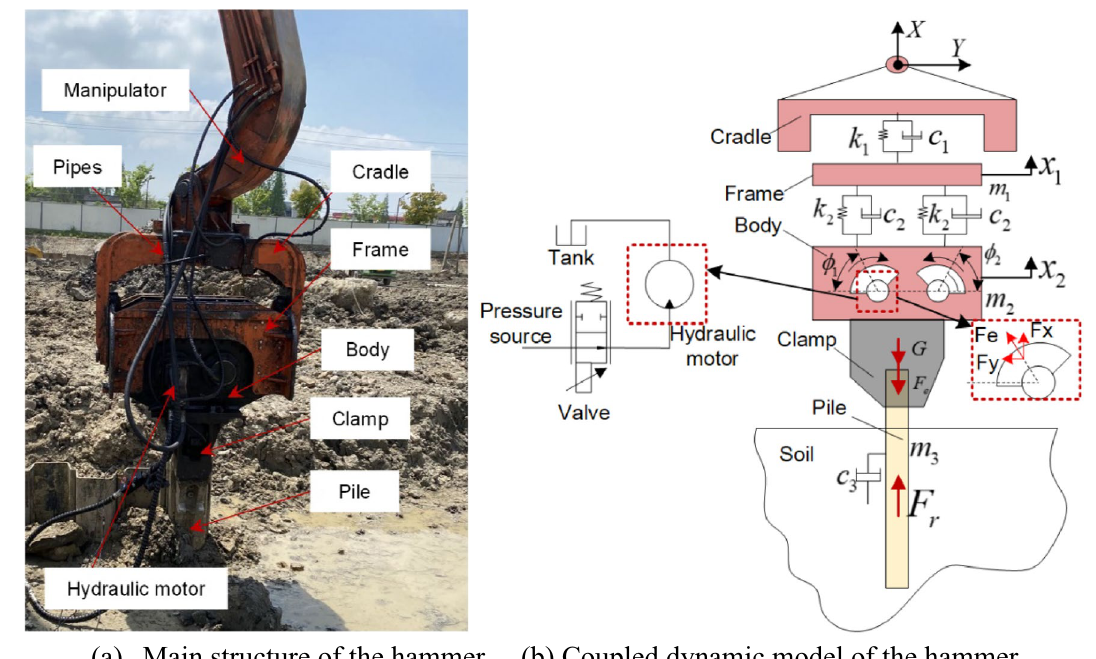
Fig. 1 Physical and coupled dynamic model of hydraulic vibratory